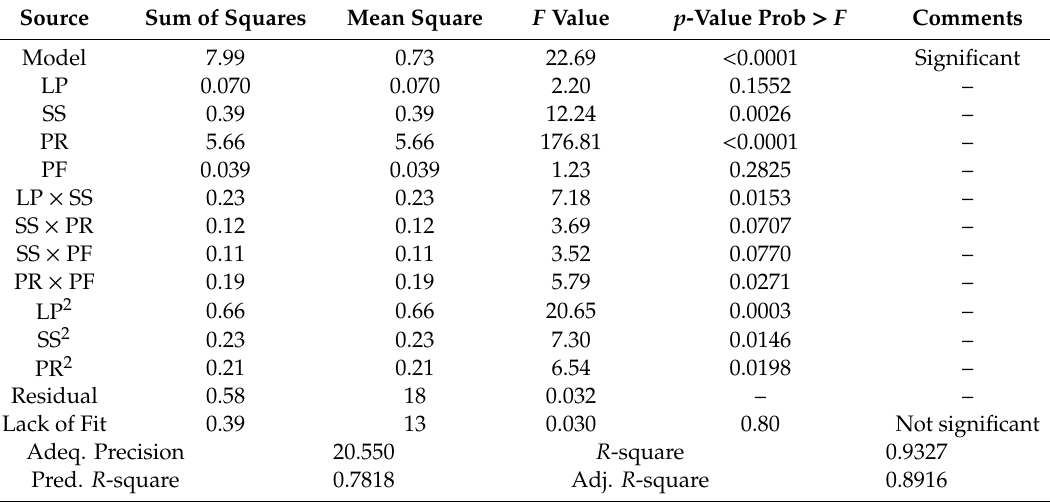
Table 5. Analysis of variance on wear volume.